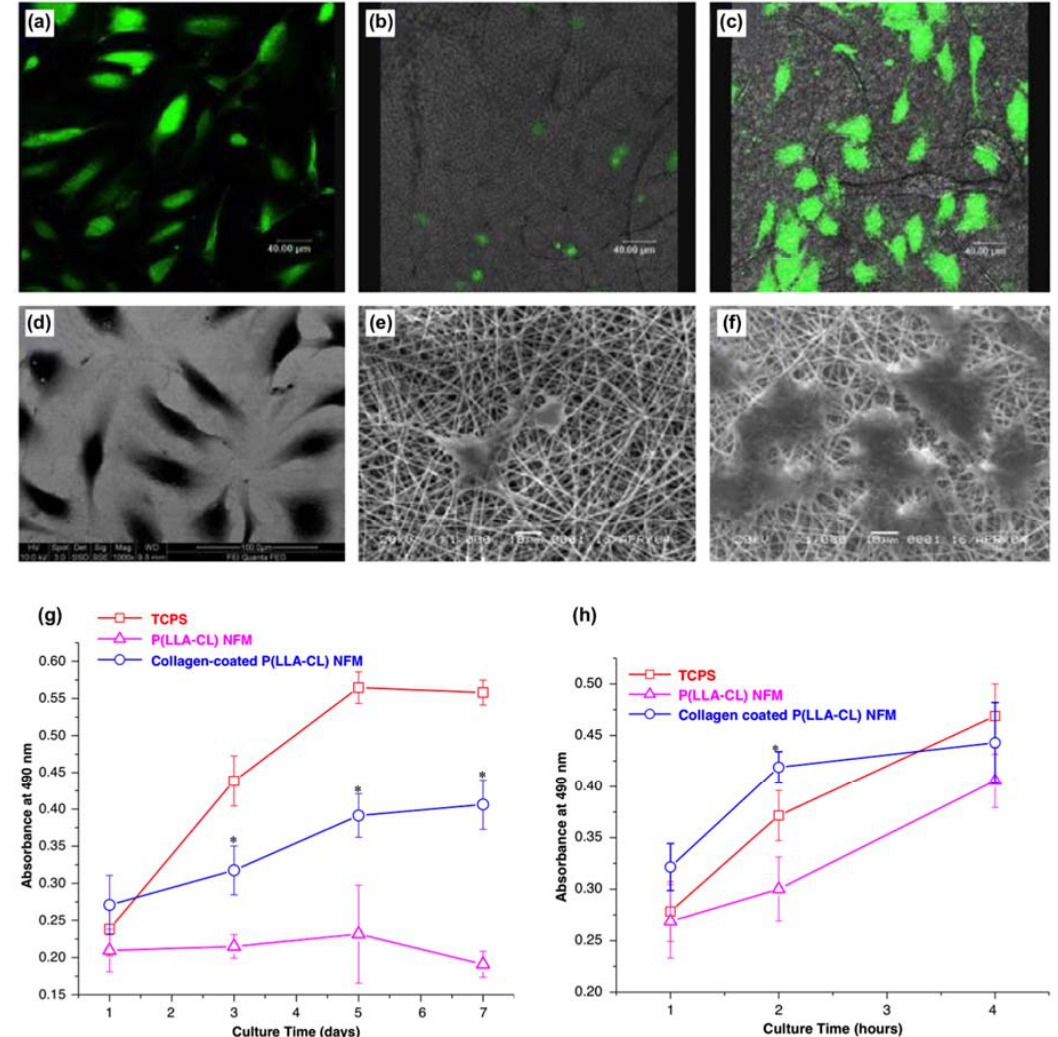
Figure 6. Laser scanning confocal microscopic and scanning electron microscopic images of human coronary artery endothelial cells cultured after three days on ( a , d ) tissue culture polystyrene plates, ( b , e ) poly( L ‐ lactic acid) ‐ co ‐ polycaprolactone nanofiber meshes, and ( c , f ) collagen ‐ coated poly( L ‐ lactic acid) ‐ co ‐ polycaprolactone nanofiber meshes. ( g ) The viability of human coronary artery endothelial cells on various substrates for seven days ( n = 3). An asterisk denotes a significance of p < 0.05 compared to the poly( L ‐ lactic acid) ‐ co ‐ polycaprolactone nanofiber meshes group. ( h ) Attachment of human coronary artery endothelial cells on various substrates after four days ( n = 3). An asterisk denotes a significance of p < 0.05 as compared to the poly( L ‐ lactic acid) ‐ co ‐ polycaprolactone nanofiber meshes group. Reproduced with permission from [162].